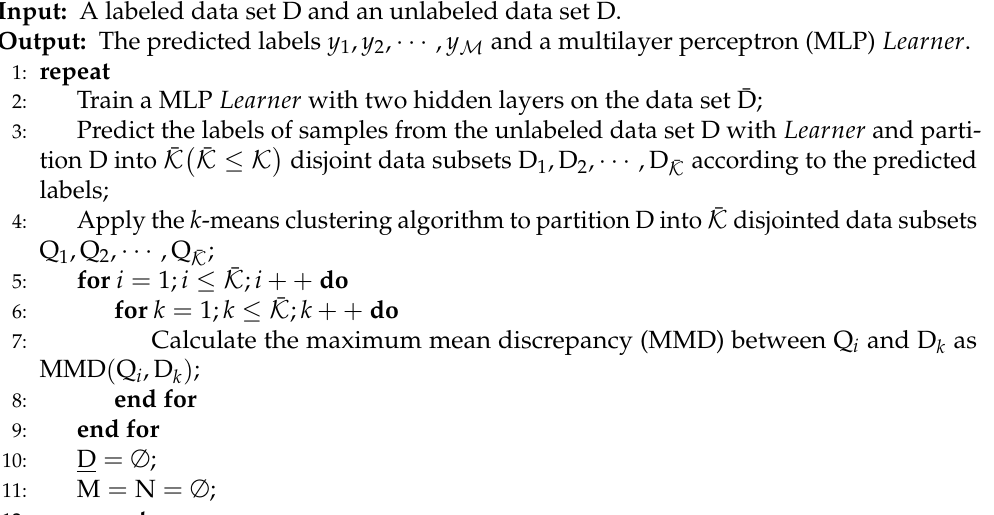
Algorithm 1 MMD-SSL